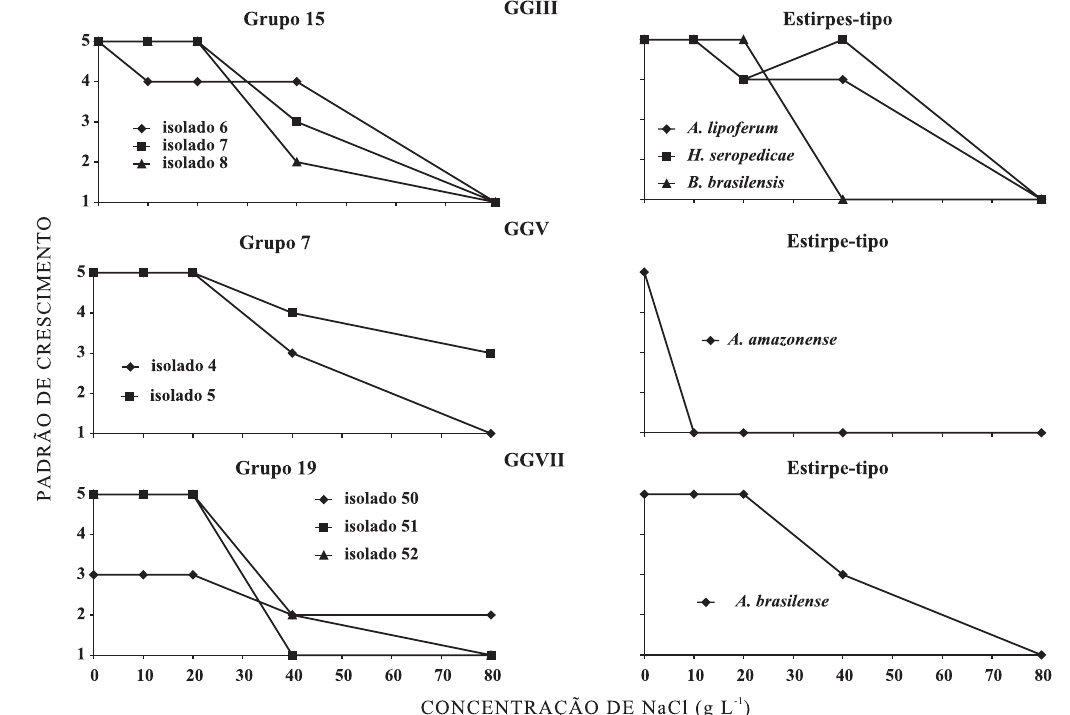
Figura 5. Teste de tolerância à salinidade dos isolados de bactérias diazotróficas não simbióticas de alguns grupos fenotípicos culturais pertencentes aos grandes grupos (GG) avaliados, referentes à coleta de